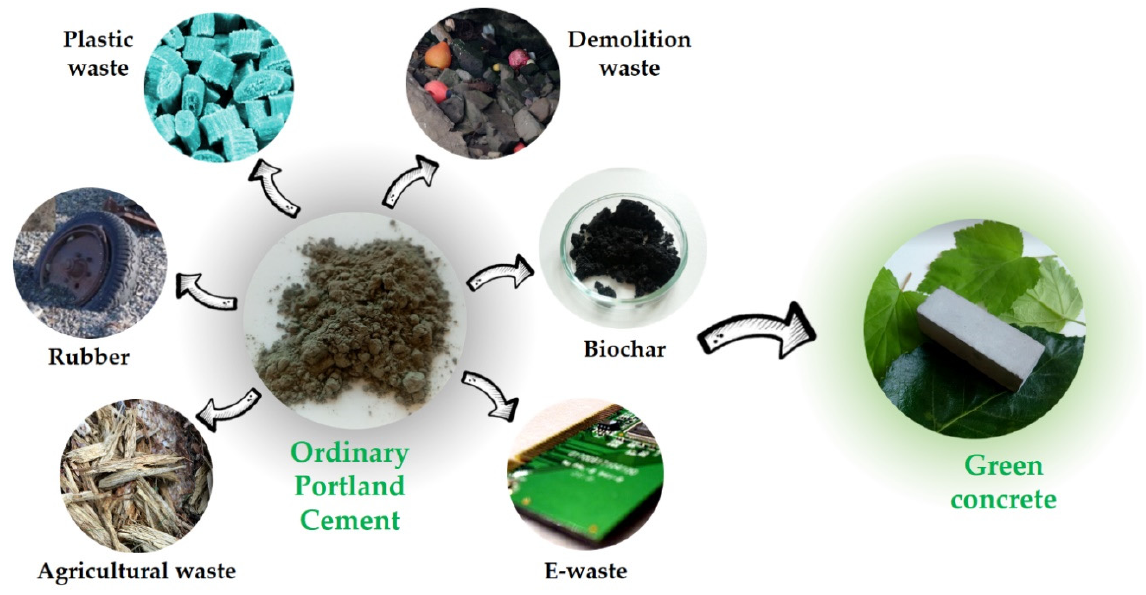
Figure 1. Schematic diagram presenting the variety of cement additives to prepare green concrete.